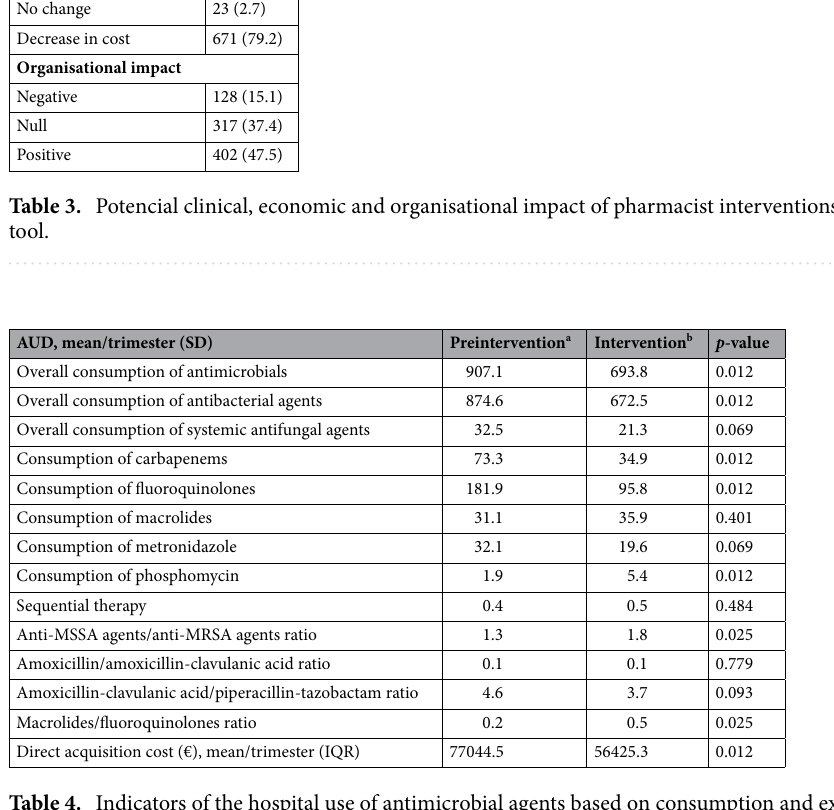
Table 4. Indicators of the hospital use of antimicrobial agents based on consumption and expenditure in the pre-intervention and intervention periods. a January 1, 2017 to December 31, 2018. b January 1, 2019 to December 31, 2020. AUD Defined daily doses (DDD) per 1000 patients-days. IQR Interquartile range, MRSA Methicillin-resistant Staphylococcus aureus , MSSA Methicillin-susceptible Staphylococcus aureus , SD Standard deviation.